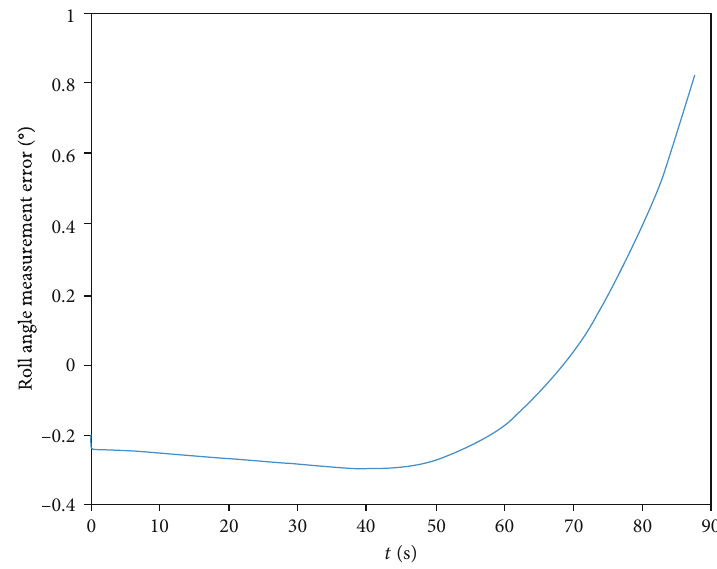
Figure 3: Roll angle error input with yaw